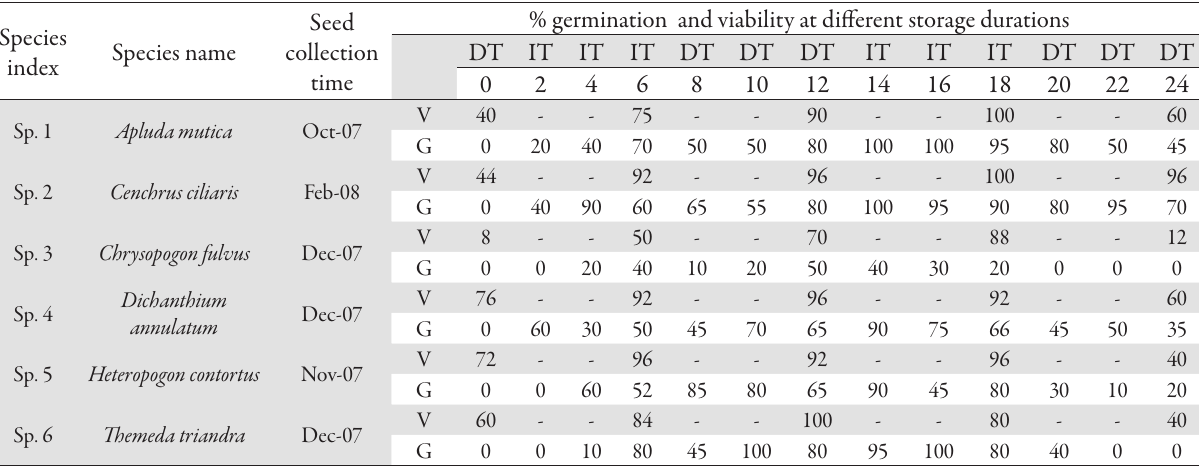
Tab. 1. Dormancy/germination responses of the selected grass species